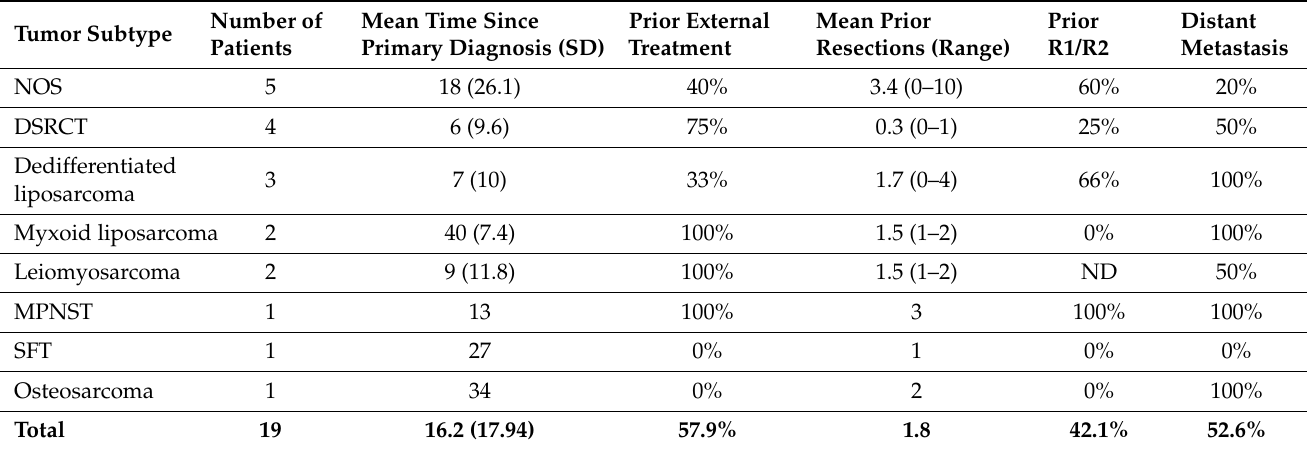
Table 2. State of disease at discovery of peritoneal